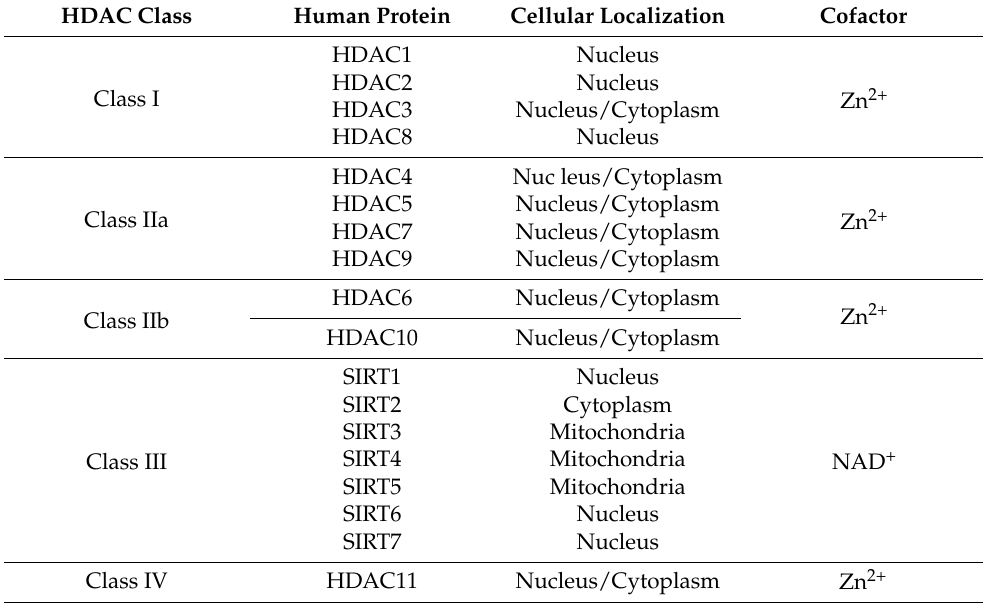
Table 1. Classification of HDAC family